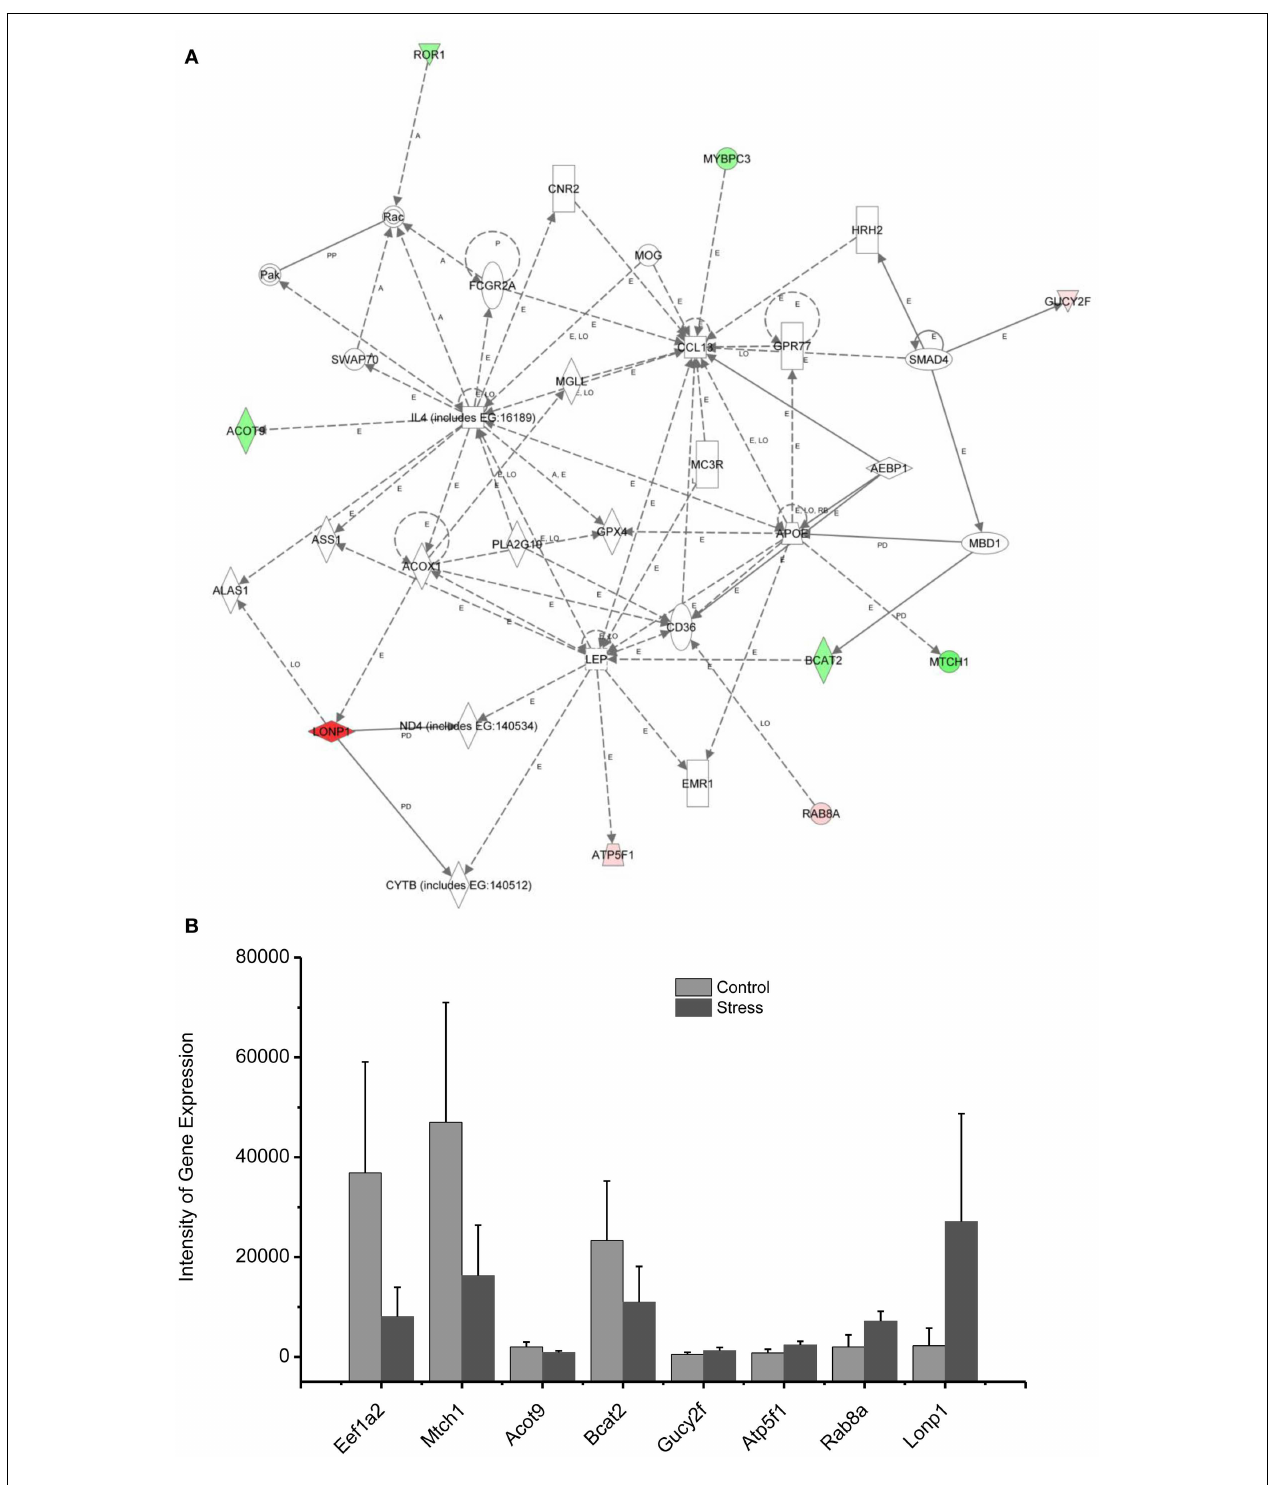
( p < 0.01, n = 10) in the network associated with LEP and CL1 in the amygdala 14days after stress.The order is plotted according to fold change, from downregulated with lowest negative value to upregulated with highest positive